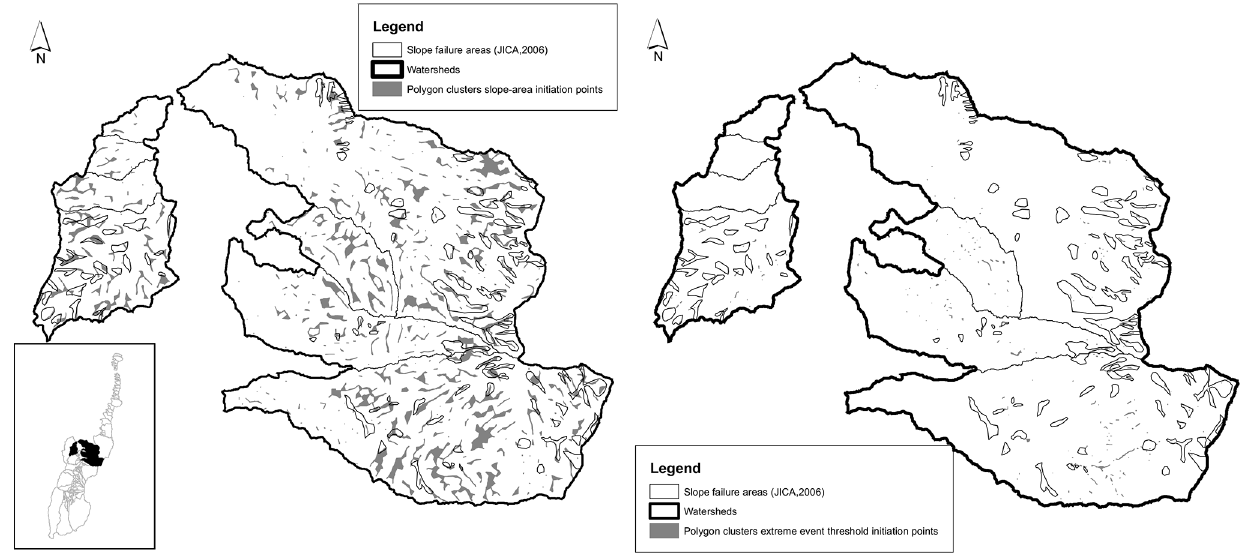
Figure 5. Comparison of failure areas detected by JICA (2006) and initiation points identified through the slope–area and the extreme event threshold.